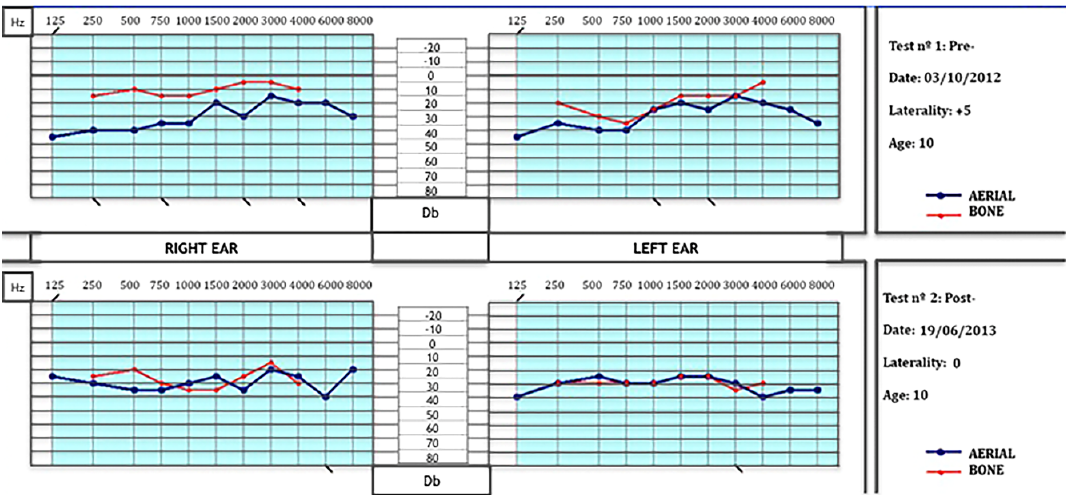
Figure 1. Aerial and bone auditive transmission pathways. Upper: Notice the low listening thresholds for all frequencies in both ears (especially for mids and lows) and the inverted curves of transmission (more in the right ear), and the spatialization errors for high frequencies. Lower: At the end of the treatment, curves of aerial and bone transmission pathways had been practically corrected and most of the spatialization errors had disappeared. (Db = decibels; Hz = Hertzs).